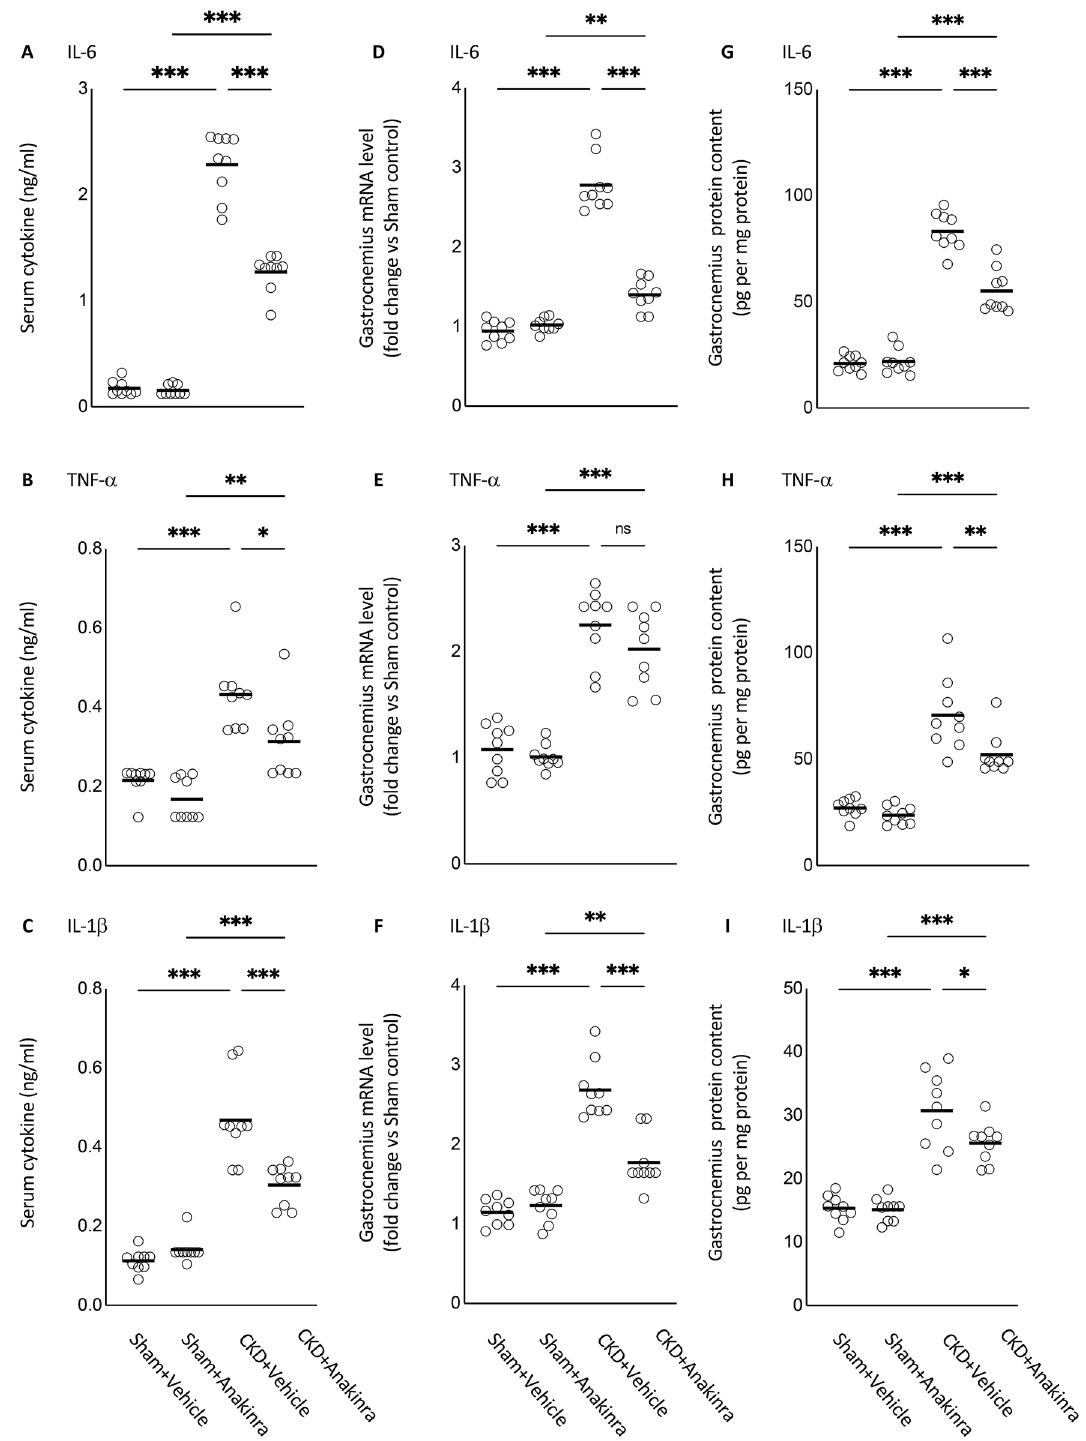
Figure 3. Anakinra attenuates serum and muscle expression of IL-6, TNF-α and IL-1β in CKD mice. At the end of 6 weeks of anakinra or vehicle treatment, WT/CKD and WT/Sham mice were sacrificed and serum cytokine concentration ( A – C ) as well as gastrocnemius muscle mRNA levels ( D – F ) and protein content ( G – I ) of IL-6, TNF-α and IL-1β were measured. Data are expressed as mean ± SEM. Results of WT/CKD + Vehicle were compared to WT/Sham + Vehicle and WT/CKD + Anakinra were compared to WT/Sham + Anakinra, respectively. In addition, results of WT/CKD + Anakinra were also compared to WT/CKD + Vehicle. * p < 0.05, ** p < 0.01, *** p <